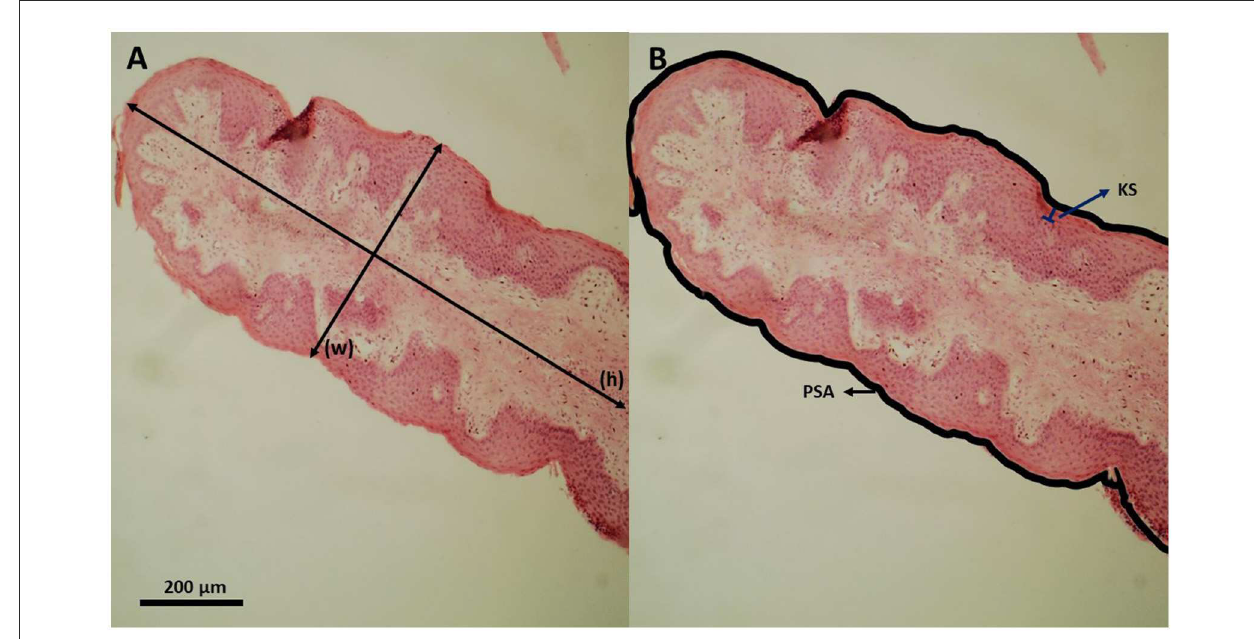
FIGURE1 Histological section of a cattle ruminal papilla; (A) Papillae height (h) and papillae width (w; measured perpendicular to papilla length). (B) Papillae surface area (PSA; thick outer line) and stratum corneum thickness (KS; keratinized surface).